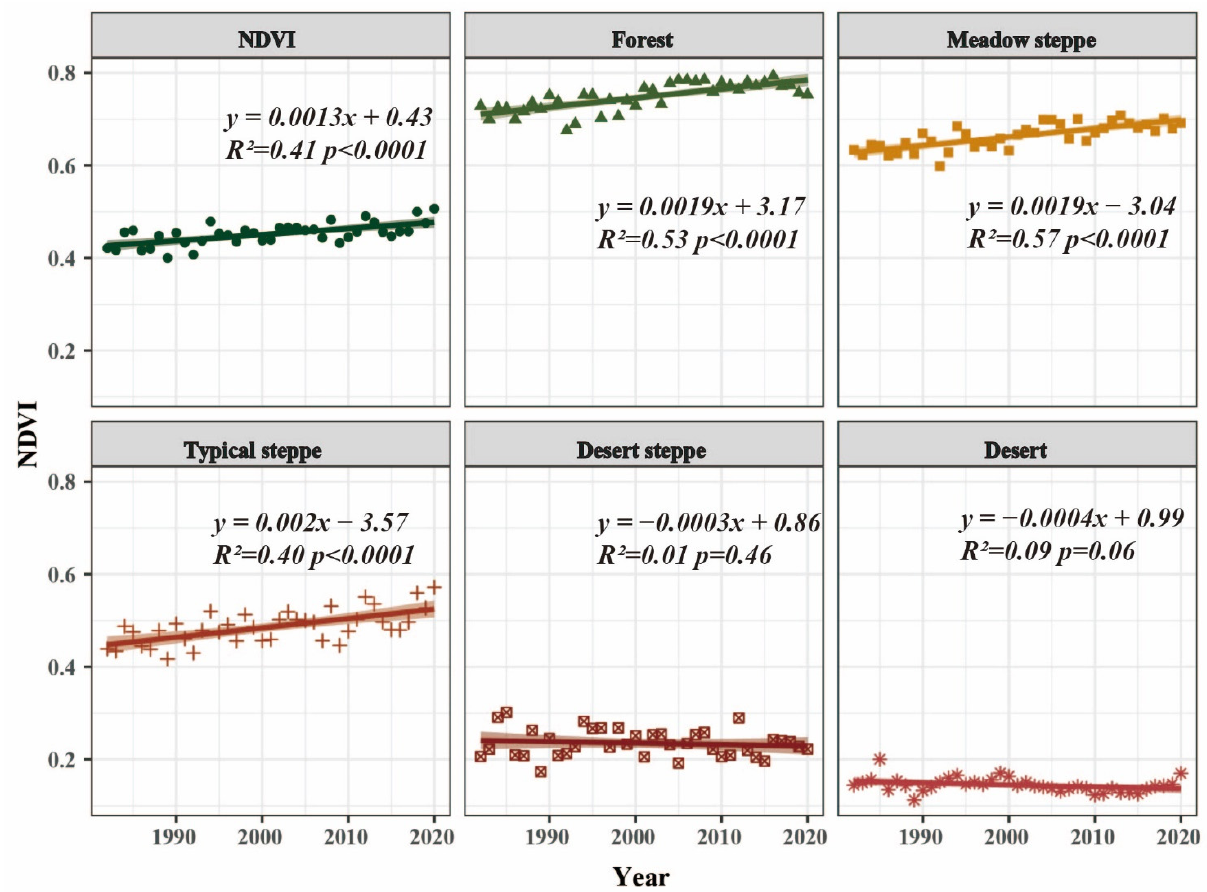
Figure 6. Variation trend of NDVI mean value of overall and each grassland type in Inner Mongolia from 1982 to 2020.